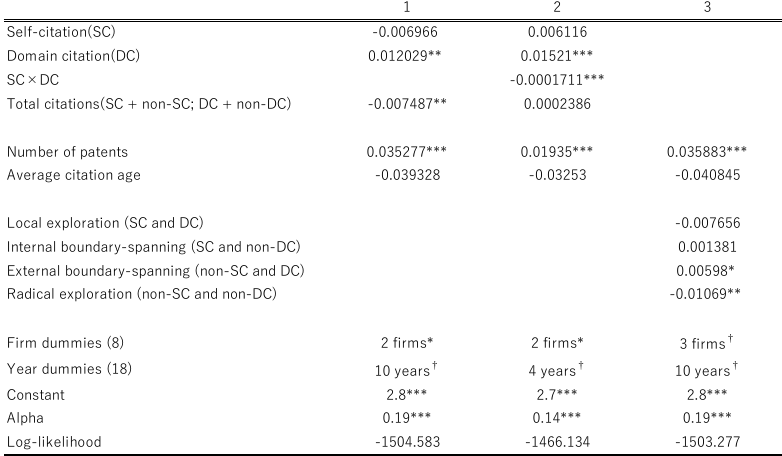
Table 6. Negative binomial regression on domain impact ( n = 168)